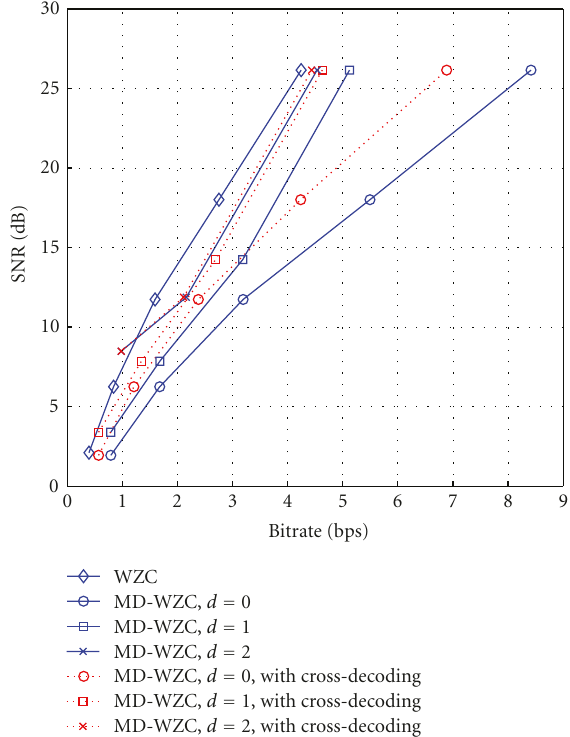
Figure 11: Central rate-distortion comparison of the MD-WZC schemes for a CSNR value of 10dB.